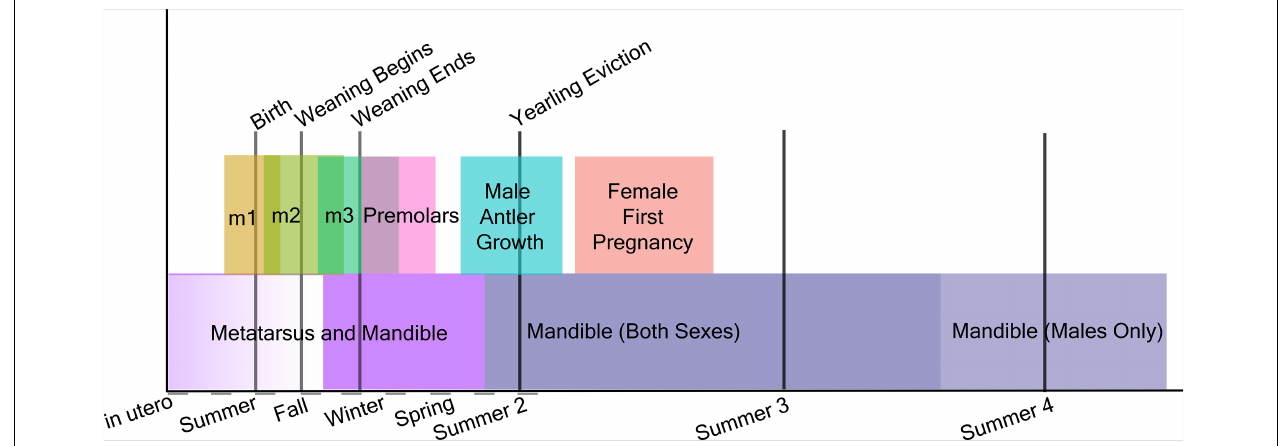
FIGURE 2 | Timeline of moose skeletal growth, tooth crown development, and metabolically significant life history